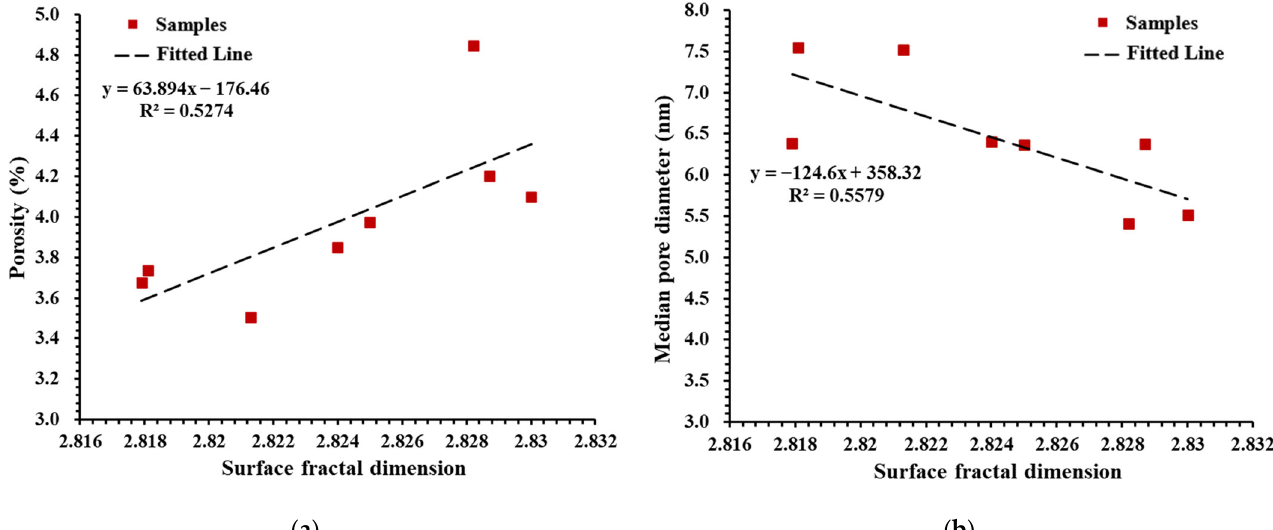
Figure 10. ( a ) Relationship between the surface fractal dimension and porosity of the deep shale samples. ( b ) Relationship between the surface fractal dimension and median pore size of the deep shale